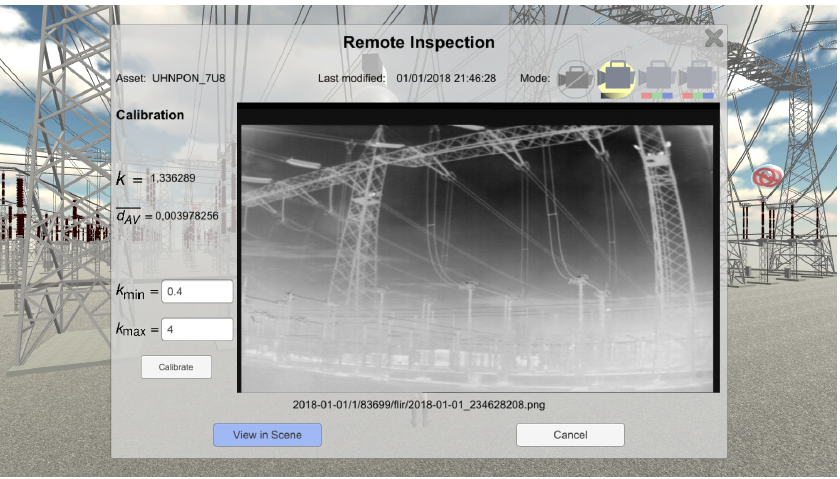
Figure 8. Field camera configuration dialog.